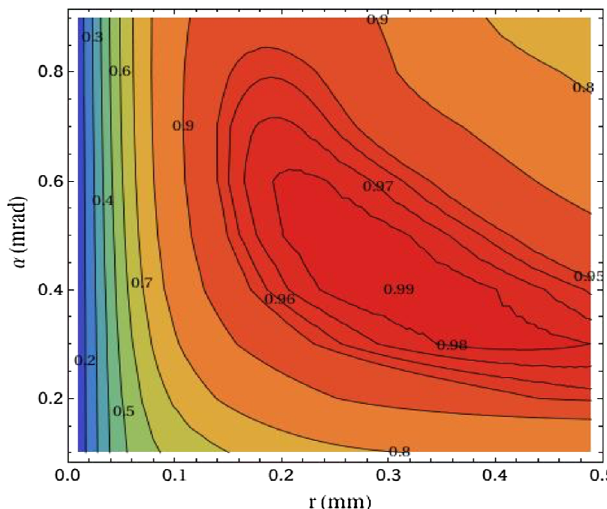
FIG. 9. Map of the stripping efficiency versus laser divergence ( α ) and laser radius ( r ).